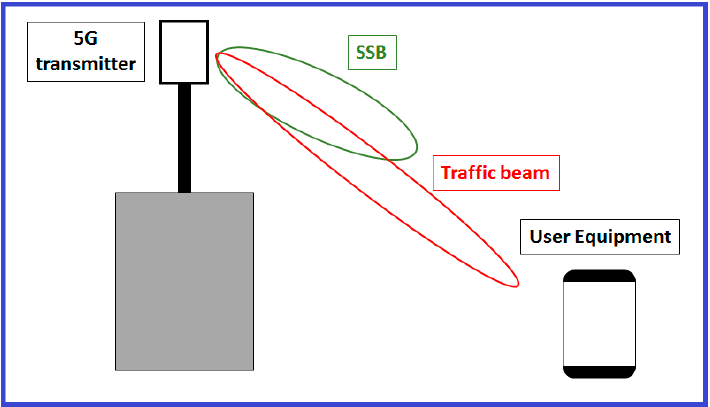
Figure 4. Representation of the effect of beamforming. While the SSBs are associated to a finite number of pre-selected beams, data traffic are transmitted using a beam focused toward the user equipment.